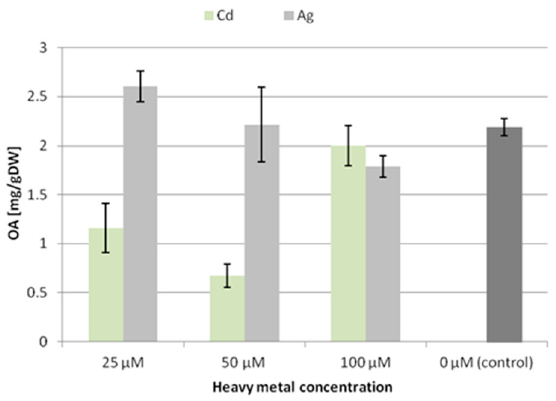
Figure 4. The content of oleanolic acid in hairy root tissue (CH2 line) after elicitation with silver and cadmium ions. OA—oleanolic acid.